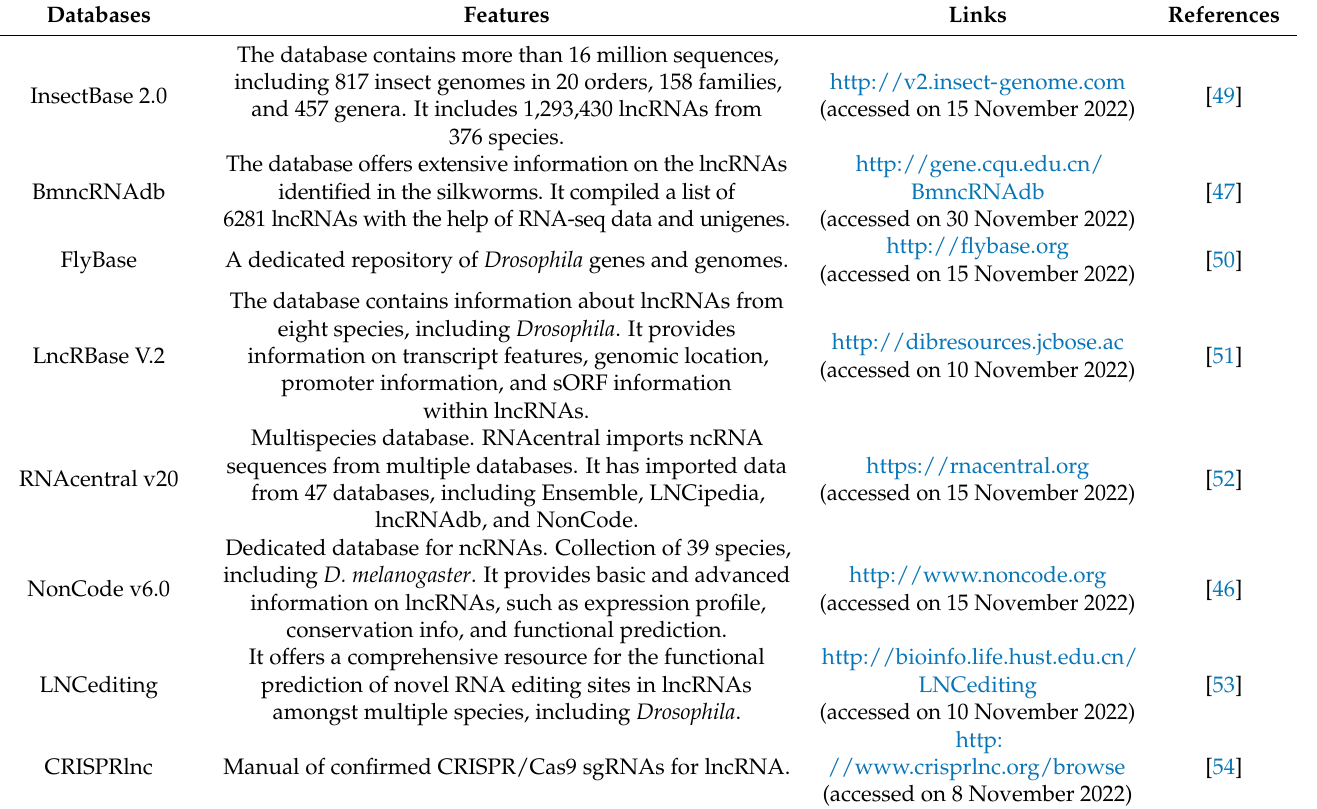
Table 1. List of some crucial databases available for lncRNA